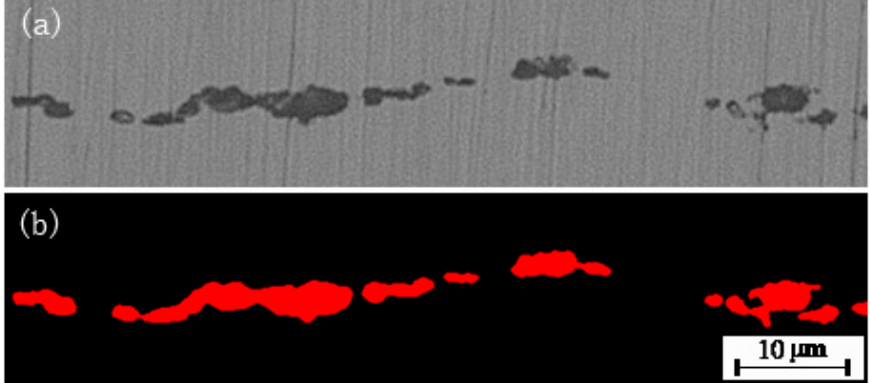
Figure 6. Image of nonmetallic inclusions: ( a ) original, ( b ) segmented by the model.